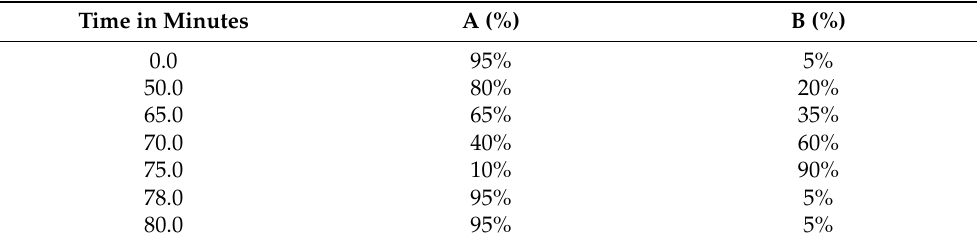
Table 1. The gradient mobile phase conditions that were utilized for the RP-HPLC analysis of the polyphenolic chemicals and flavonoids in the plant extracts. Time in Minutes A (%) B (%) 0.0